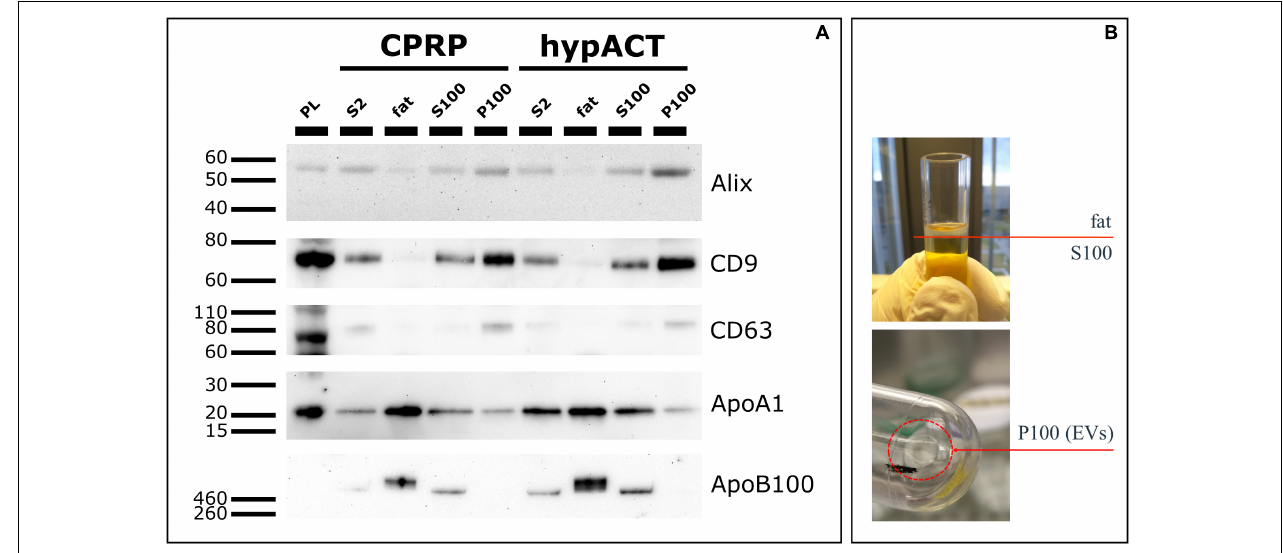
FIGURE 4 | Characterisation of protein markers via Western Blot. (A) Extracellular vesicle (EV) markers (Alix, CD9, CD63) and lipoproteins (ApoA1, ApoB100) were detected in fractions obtained after ultracentrifugation (fat, S100, P100). Platelet lysate (PL) and S2 fraction (pre-cleared blood product supernatant) were used as positive controls. 10 µ g total protein per lane, except for PL (20 µ g) (B) Graphical representation of fractions fat, S100 and P100 obtained after an UC run.